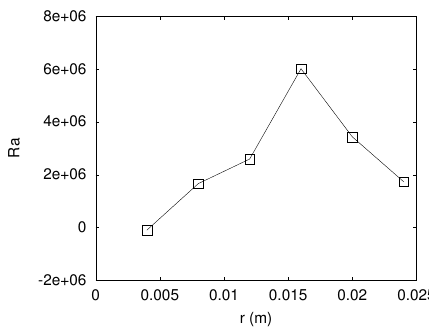
Figure 6. Radial variation of the spatially-averaged Rayleigh index.